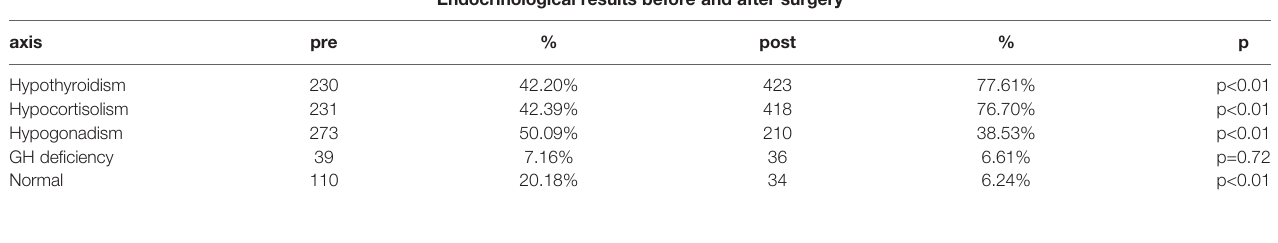
TABLE 2 | Summary of endocrinological in pre and postoperative period. Endocrinological results before and after